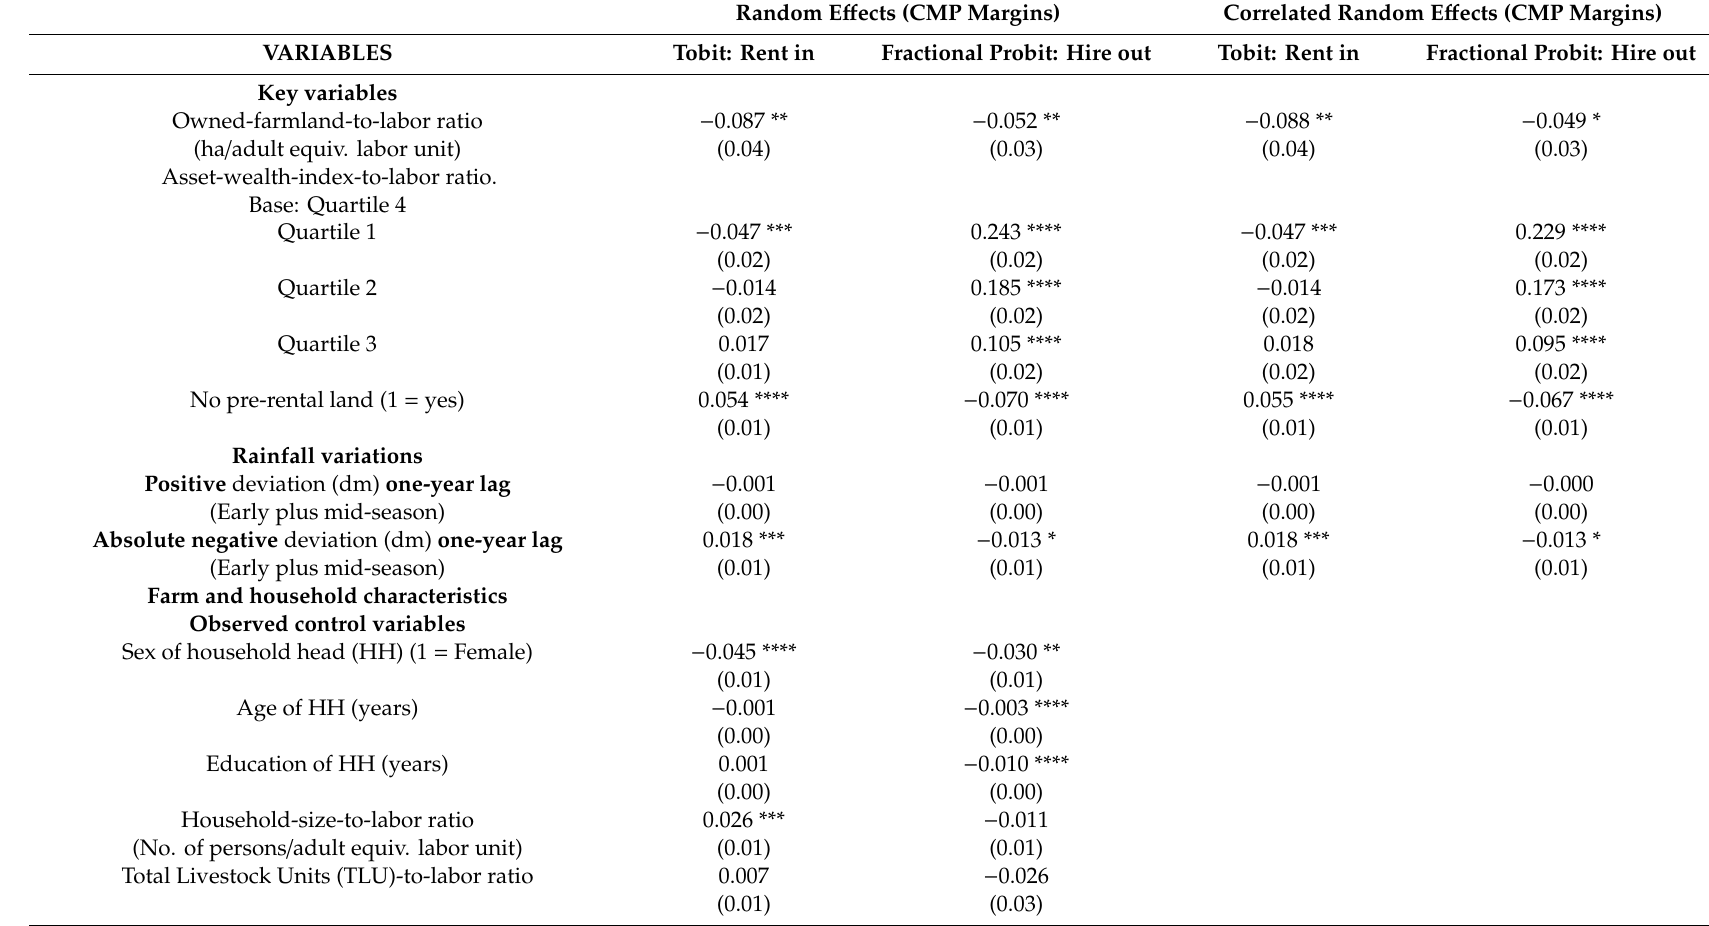
Table A4. Conditional mixed process (CMP) margins from a systems approach using Tobit for the land rental markets and fractional probit for the share of adult equivalent labor hired out for casual work ( ganyu